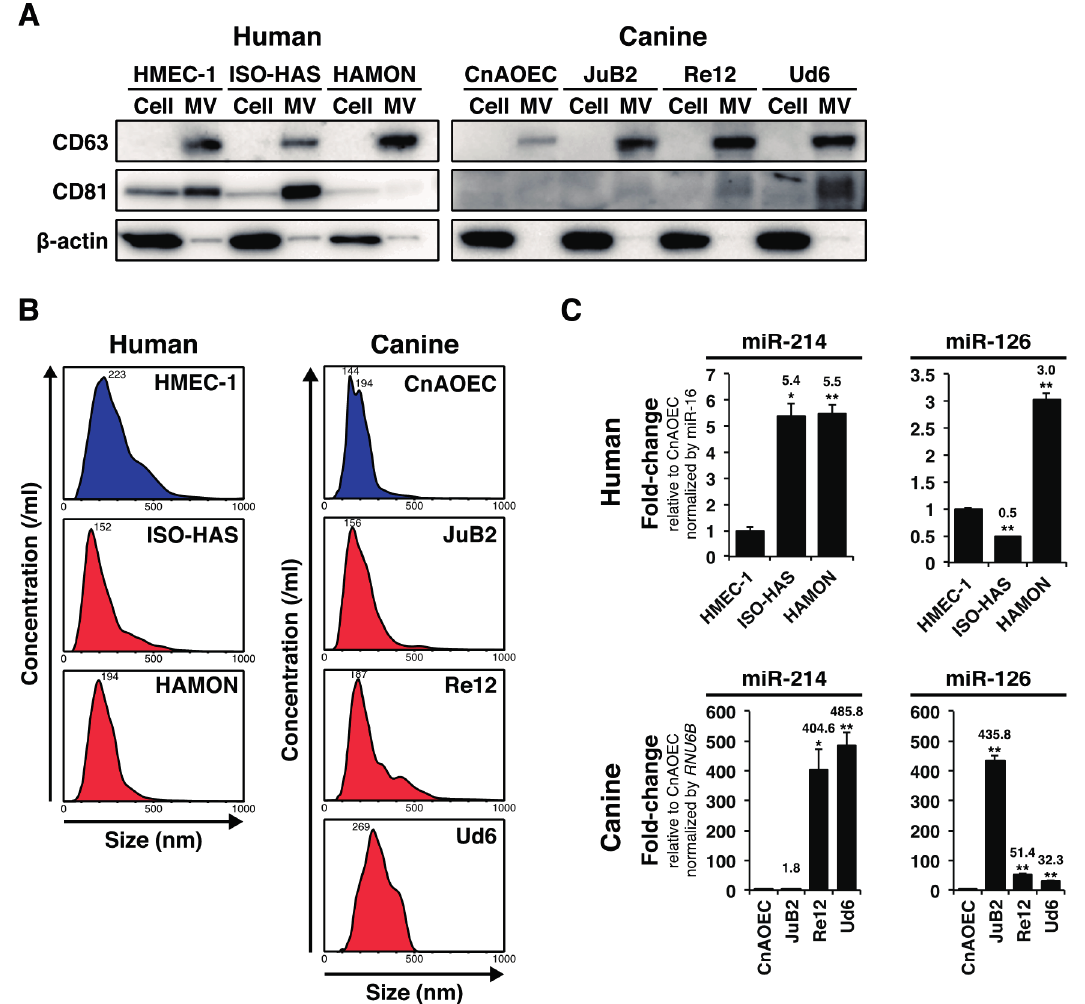
Figure 1. AS and HSA cell lines over-secreted miR-214 and miR-126 via MVs. ( A ) Immunoblotting for MV-markers: CD63 and CD81. The nanoparticles from all cell lines expressed CD63 or CD81 although CD81 was absent or weakly detected in MVs derived from HAMON, CnAOEC, JuB2, and Re12. β -actin was used as a negative control for excluding contamination by cellular contents; ( B ) Nanoparticle tracking analysis for AS and HSA cell lines and control ECs. The peaks of MV diameters showed a range of 144–269 nm, indicating that AS, HSA cell lines and control ECs mostly secreted MVs having a diameter of over 100 nm; ( C ) Quantitative measurement of miR-214 and miR-126 in the MVs from the conditioned media from AS, HSA cell lines and control ECs. The levels of miR-214 were significantly increased in the conditioned media of AS and HSA cell lines compared with those for the control cell lines. The levels of miR-126 were also increased likewise, except in the case of ISO-HAS. The degree of increase in canine cell lines was dramatically higher than that in human cell lines. All data are presented as the mean of triplicate experiments with error bars indicating the s.e.m. (Unpaired two-tailed t -test; * p < 0.05, ** p < 0.01 for comparisons with the levels of control cell